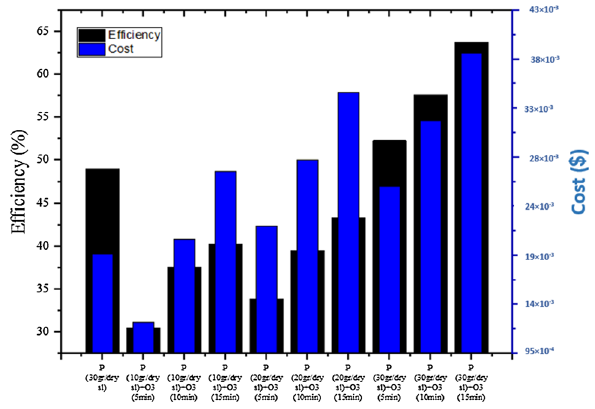
Fig. 9 Cost and effectiveness of each